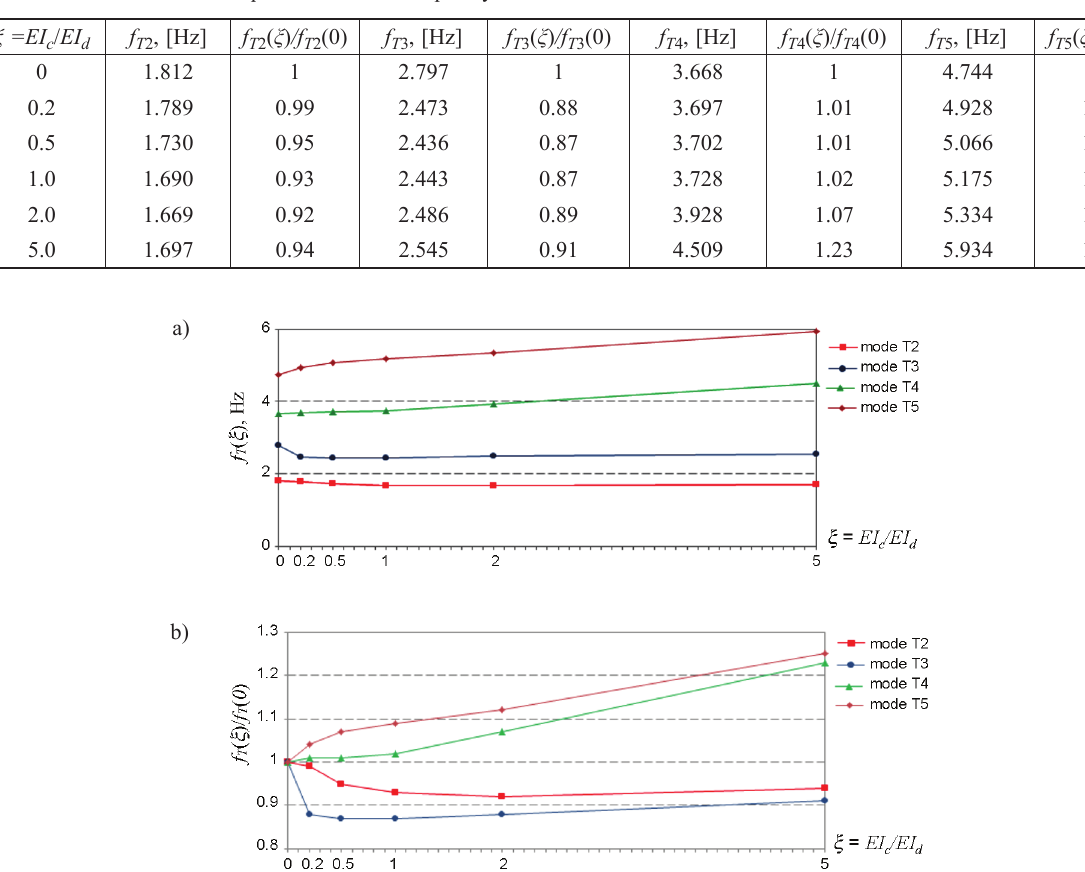
Fig. 8. The effect of the stiffness parameter ξ of the cable on the natural frequencies of torsional modes (a) and the frequency ratio of the system with stiffened cables, f T ( ξ ), and that of the original system, f T (0)